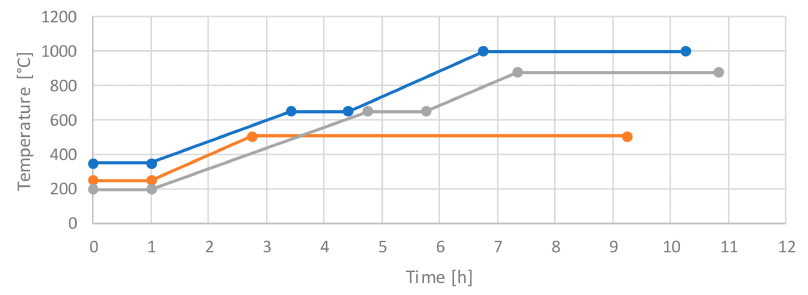
Figure 3. Di ff erent temperature profiles for di ff erent heat treatment processes.